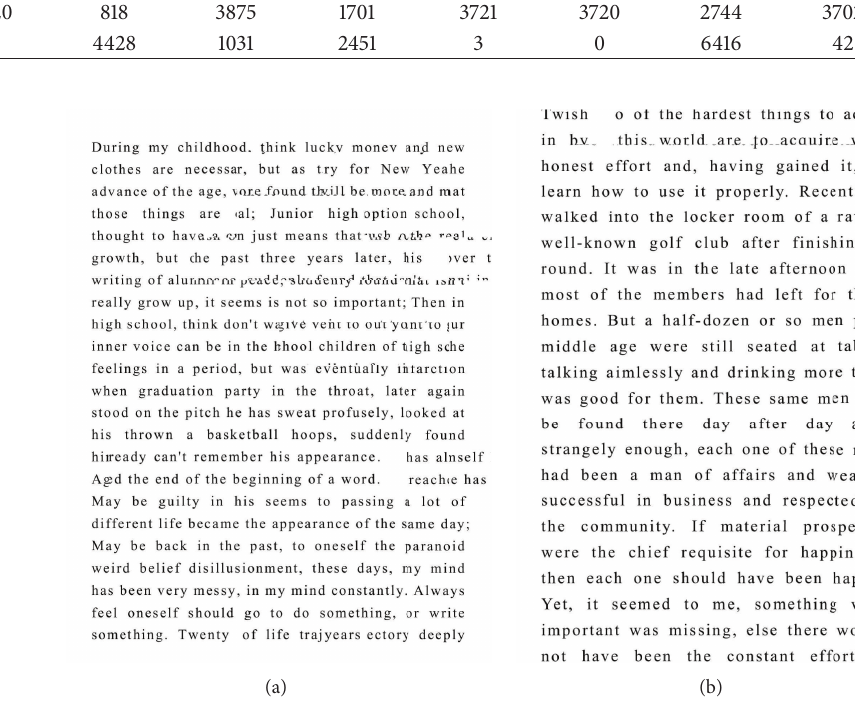
Figure 13: The first reconstructed document (a) and the second reconstructed document